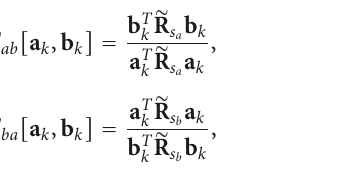
the number of wLPCCs q = 12 are chosen, although these choices are not critical. Each training pattern is preprocessed so that its mean value, averaged over the entire training set, is close to zero. Each pattern (vector) is normalized so